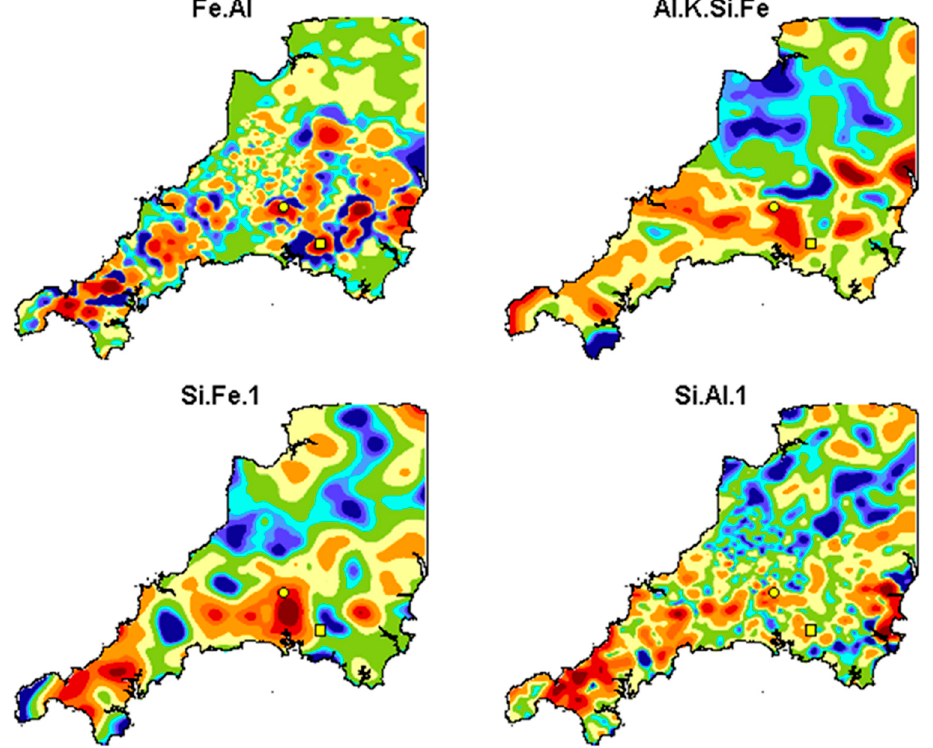
Figure 11. Relative distributions in deciles of the concentration of the 4 ISCs associated with bioaccessible As. Colours follow percentile gradient in Figure 12. symbol indicates location of the Devon Great Consols mine and the (cid:3) symbol indicates the location of the Hemerden mine.